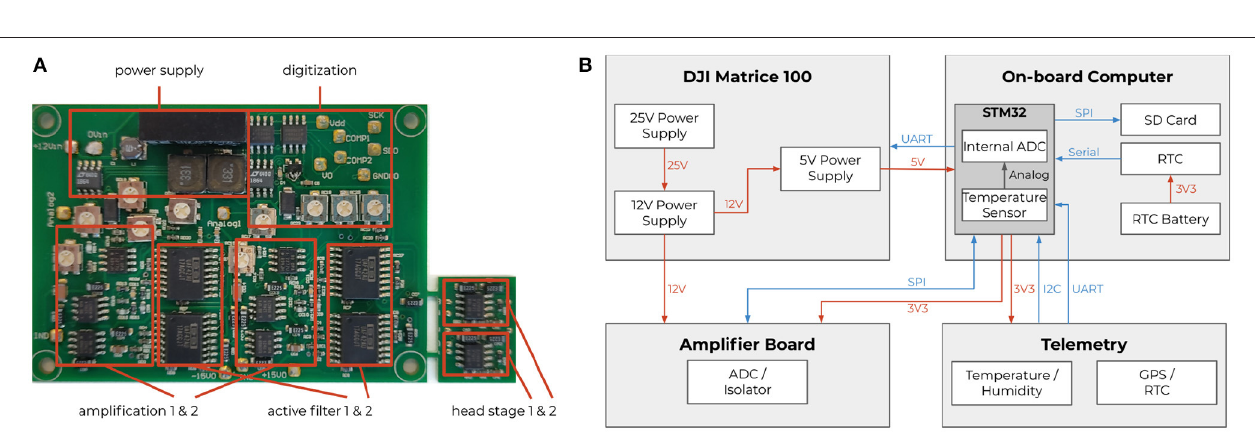
FIGURE 3 | Extracellular amplifier and data flow. (A) Photograph of the custom two-channel extracellular amplifier. The design contains two head stages to convert the impedance. They are located close to the bee’s head. Each analog signal is then processed separately by amplifiers (amplification factor: 1,000x) and active filters (bandpass: 300 Hz–10 kHz). The resulting analog signals were then digitized by two synchronized delta-sigma analog to digital converters (16 bit, 20 kHz sampling frequency). Two galvanic isolators isolated the digital signals to not pick up any noise from the data storing microcontroller (STM32F4). (B) Schematics of the system with a STM32F4 as on-board computer. Diagram of all electrical components of the neurocopter system and the used buses additionally to the components which are parts of the DJI Matrice 100 quadcopter. The blue arrows represent data transfer. The direction of an arrow symbolizes the direction of the information flow. The red arrows show power supplies and their respective voltages. To make the code hardware independent, the STM32 cube hardware abstraction layer was used for hardware